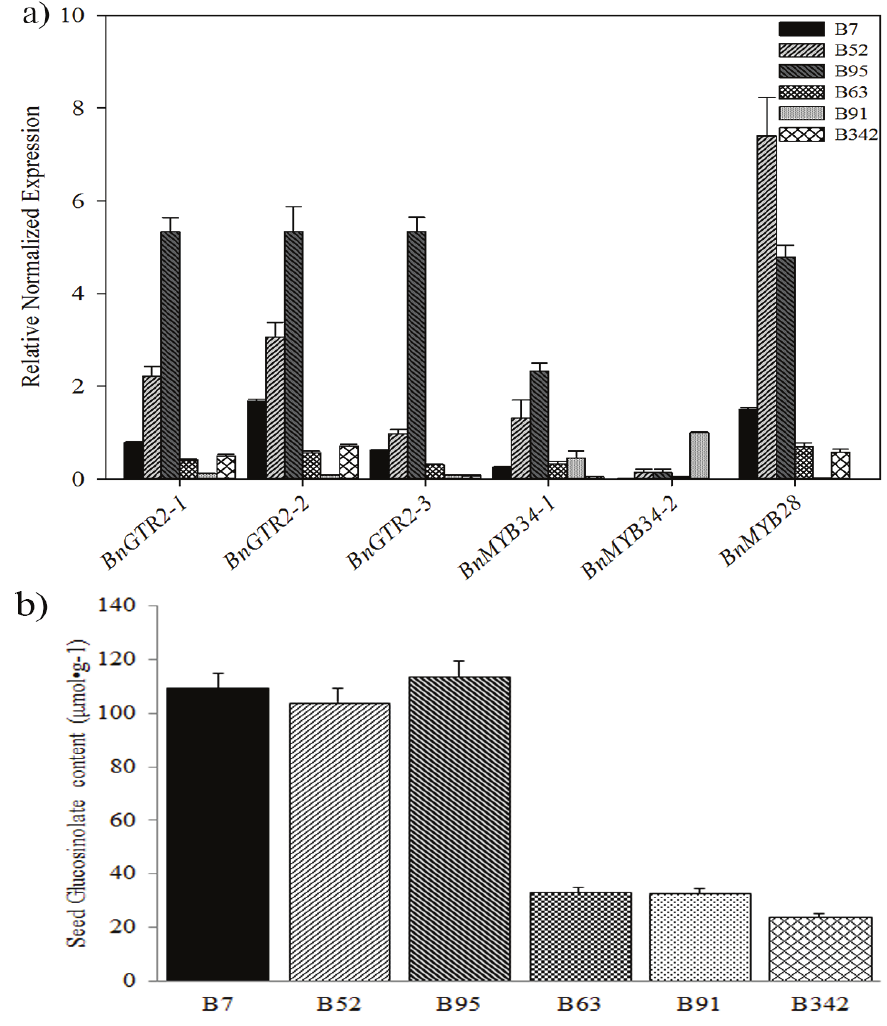
Figure 6. Relative expression of the candidate genes and seed glucosinolate content of B. napus accessions. ( a ) Relative expressions of the candidate genes detected by qRT-PCR. The expression levels were normalized with BnActin7 and BnUBC21 genes. Error bars indicated the SE for three independent experiments. The primers are listed in Supplementary Material, Table S2 on the journal’s website. ( b ) Means and standard error of seed glucosinolate content of six B. napus accessions in 2013 and